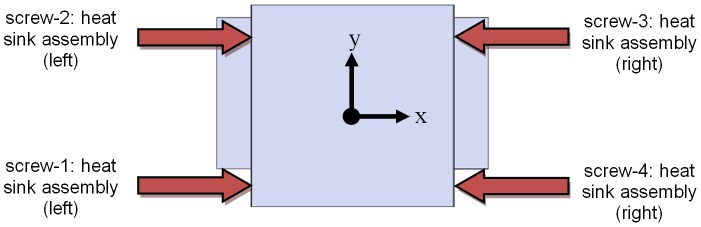
Fastening sequence.